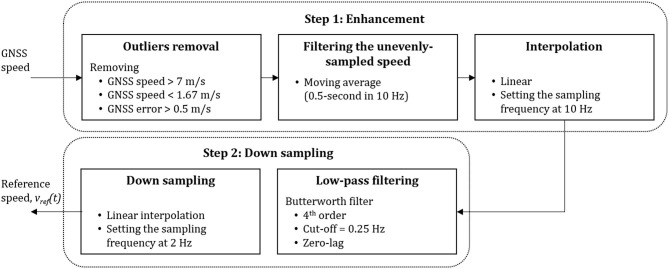
Pre-processing steps applied to the GNNS measurements of speed to obtain the reference speed estimation. This figure was adapted from Soltani et al. (2019).